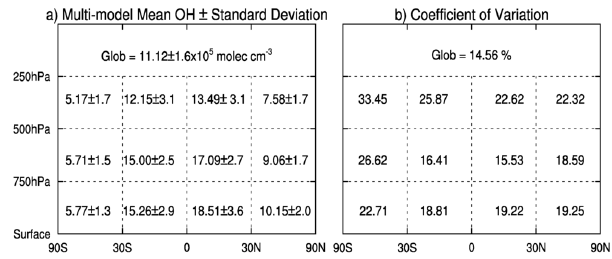
Fig. 1. (a) Multi-model mean regional annual mean airmass- weighted OH concentrations ( × 10 5 molecule cm − 3 ) and (b) the coefficient of variation (CV; standard deviation as percentage of the multi-model mean) for 2000 in the atmospheric subdomains recom- mended by Lawrence et al. (2001). Global mean tropospheric OH concentration and CV are shown in the topmost row of each